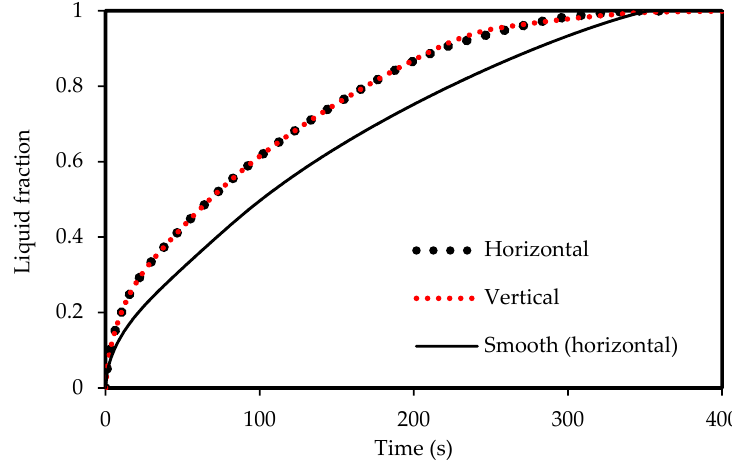
Figure 5. Liquid-fraction evolution during melting in the horizontal and vertical corrugated channel compared with smooth horizontal channel.